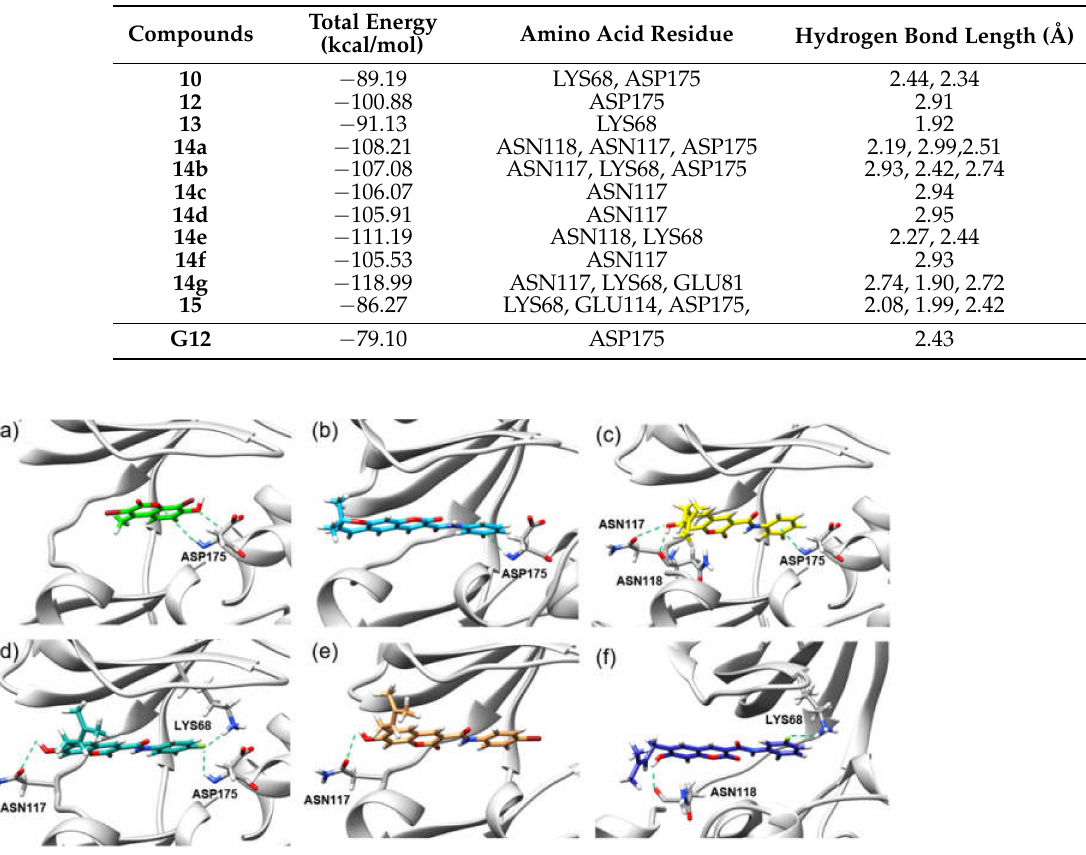
Figure 3. Hydrogen bond interactions in the bindings of ( a ) G12 ,( b ) 12 ,( c ) 14a , ( d ) 14b ,( e ) 14d , and ( f ) 14e in the CK-2